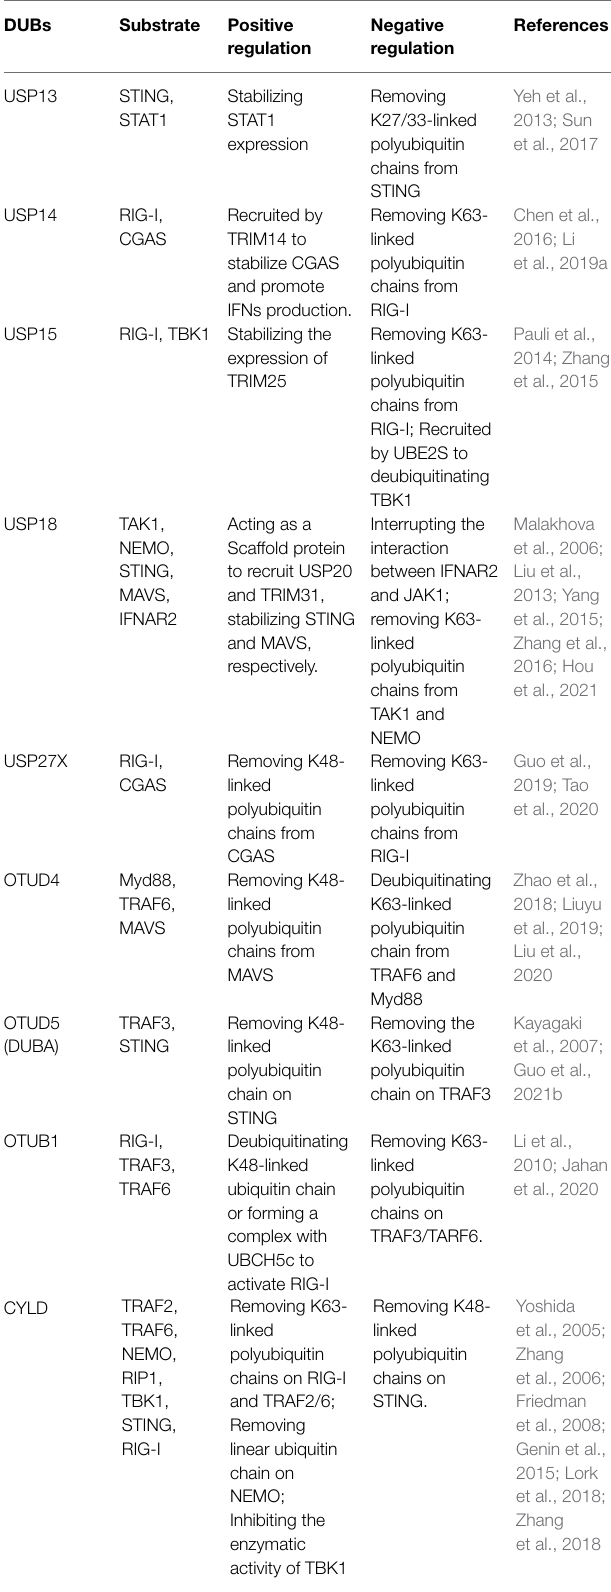
TABLE 1 | The multiple roles of deubiquitylating enzymes (DUBs) in pattern- recognition receptor (PRR)